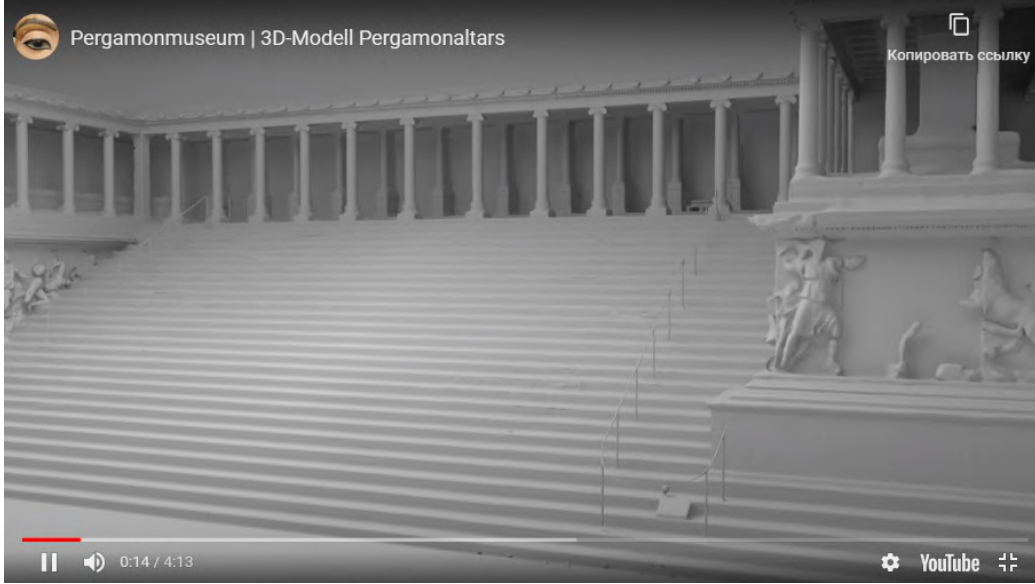
Figure 61: Presentation of paper